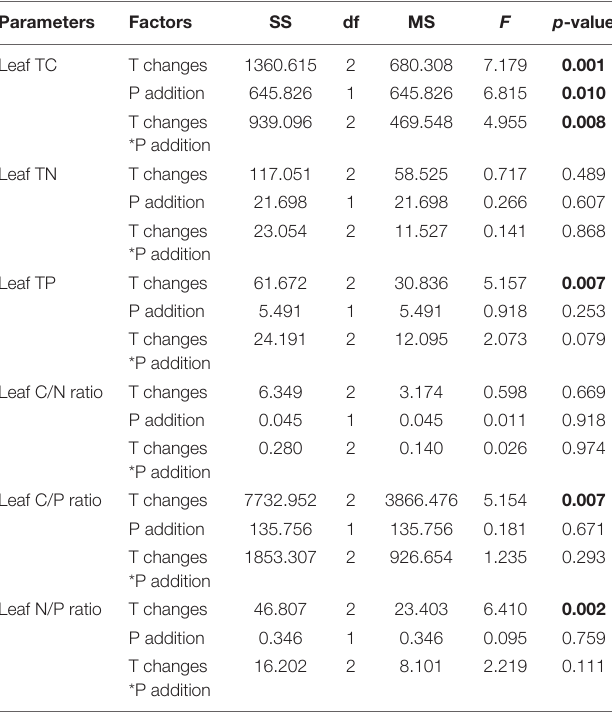
TABLE 1 | Effects of different temperature scenarios and phosphorus addition on the TC, TN, and TP contents and the C/N, C/P, and N/P ratios in P. crispus leaves.